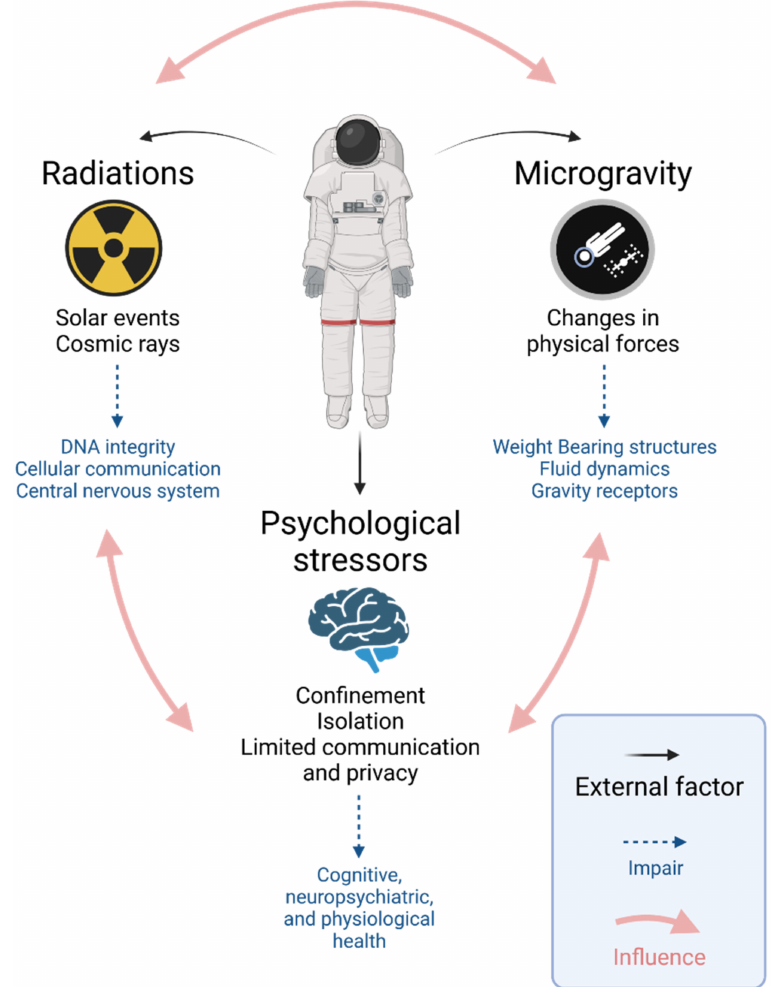
Figure 1. Overview of stressors and health challenges associated with spaceflight. The physical and psychological impacts of spaceflight are not restricted only to their specific stimuli but can also influence each other, resulting in a complex interplay that can have extensive health consequences for space